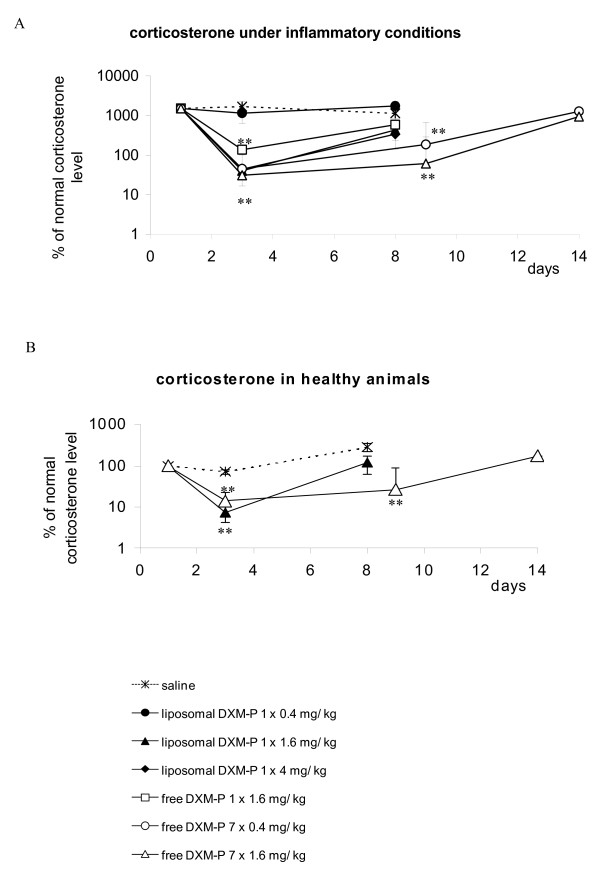
Impact of liposomal and free dexamethasone phosphate on corticosterone. Corticosterone levels in the blood of (a) arthritic animals or (b) healthy animals were measured following treatment with liposomal dexamethasone phosphate (DXM-P), free DXM-P or saline. **P ≤ 0.01 Mann-Whitney U test versus saline. n ≥ 6 for all groups; mean ± standard error of the mean.